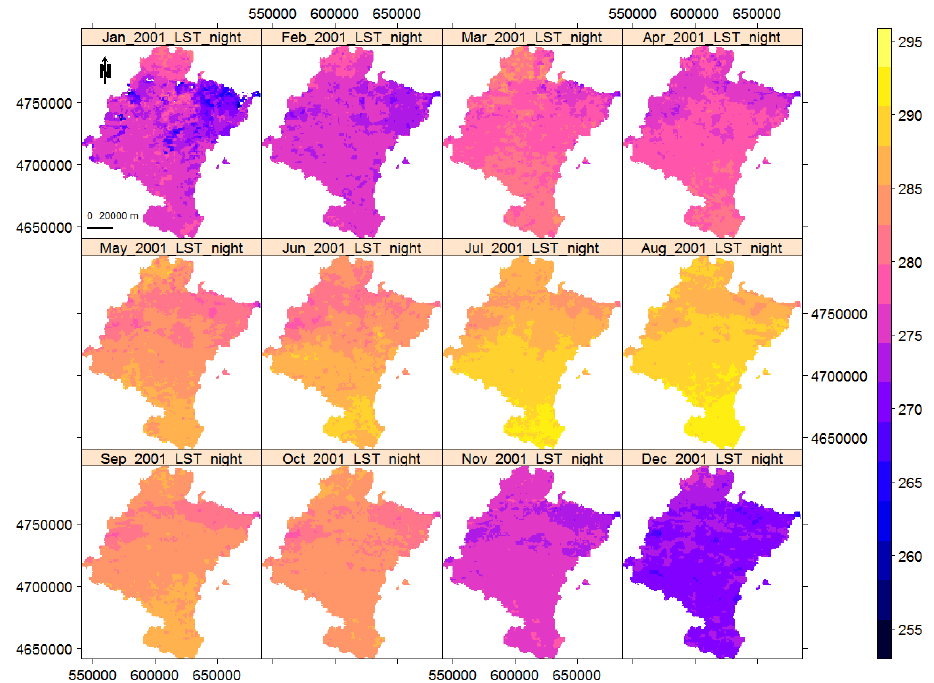
Figure 11. From the top-left to the bottom-right: monthly LST night (in Kelvin degrees) of Navarre, Spain, from January to December of 2001, in which the variation across the region and changes over months are